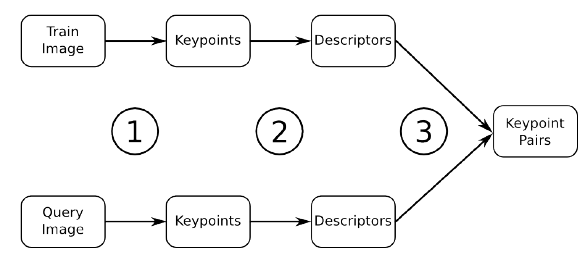
Figure 1. Feature points detection, descriptors extraction and feature